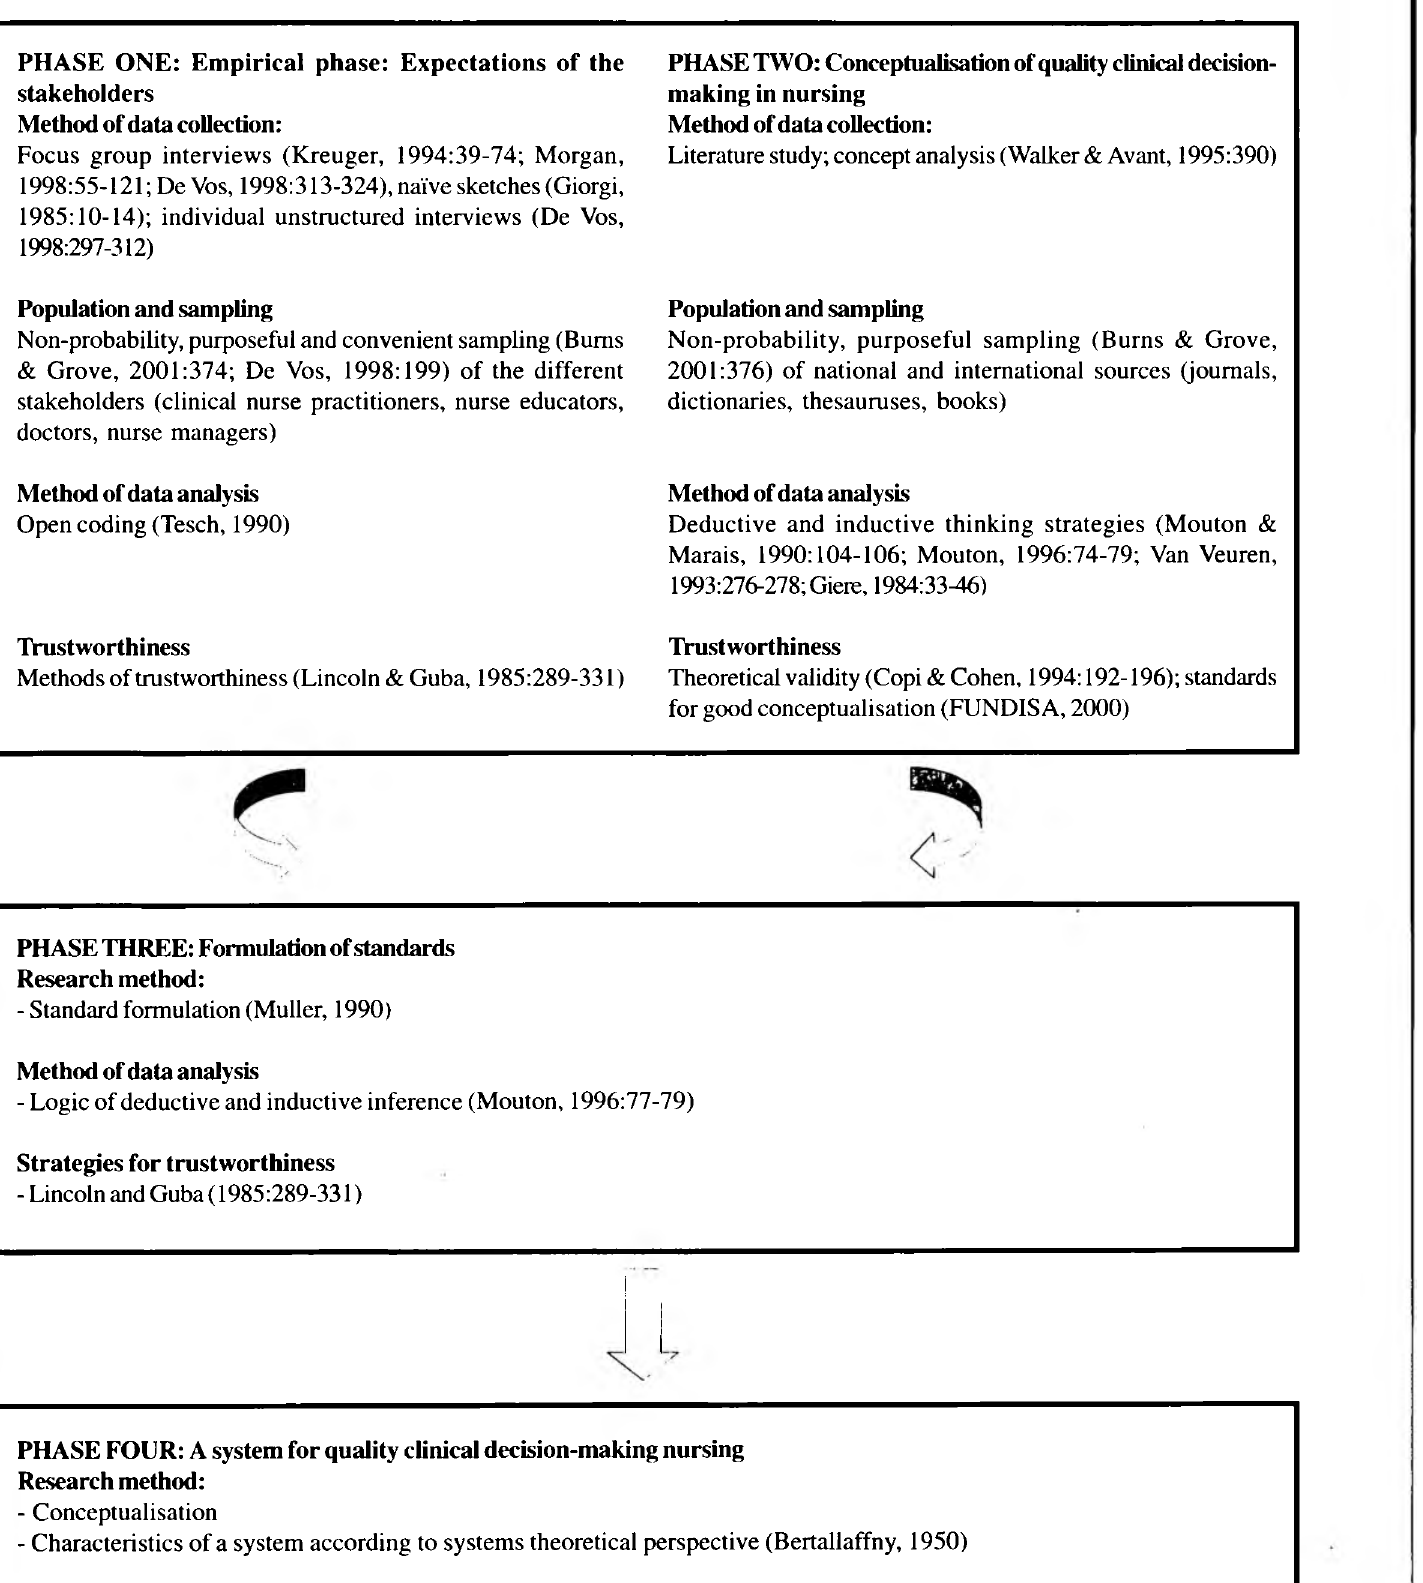
Table 1: Schematic presentation of research phases, design and methods